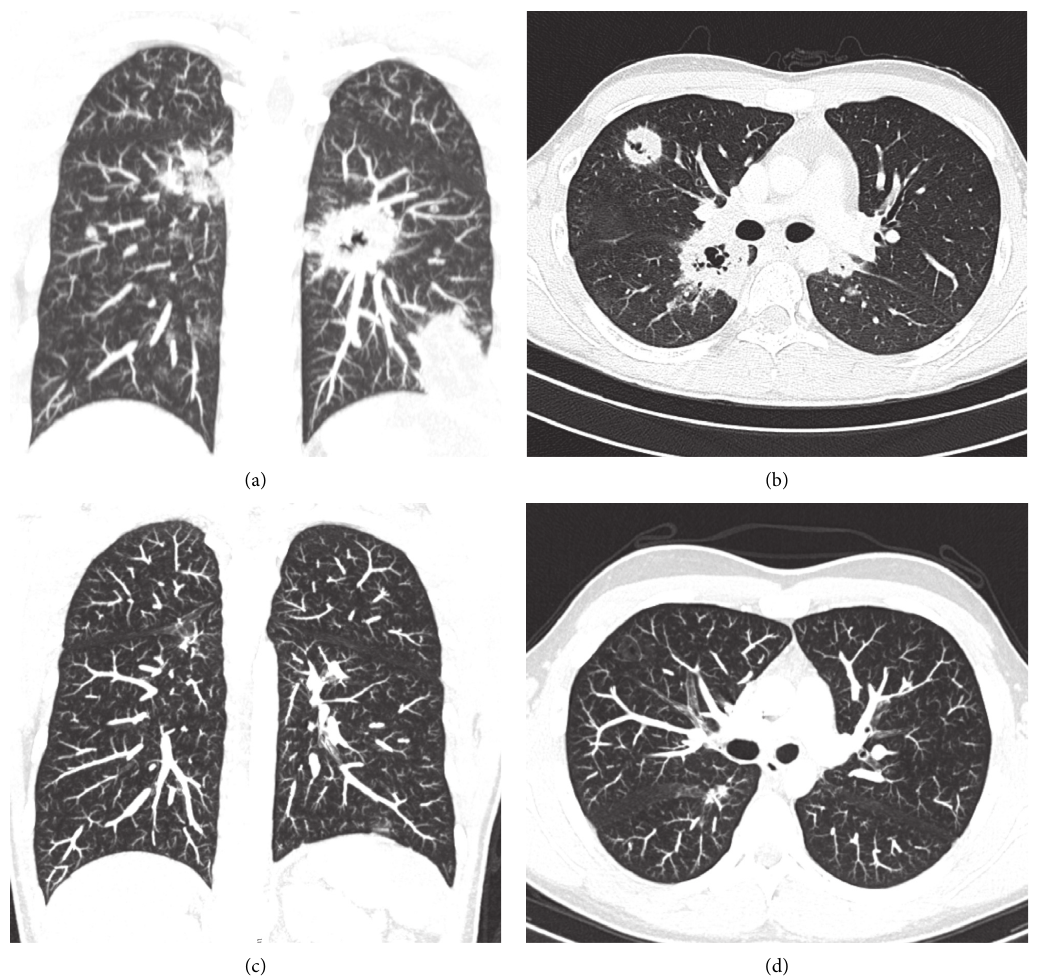
Figure 1: CTscan showing parenchymal nodular areas with internal cavitation (a, b) with almost complete resolution after 4 months (c, d), Case 1.